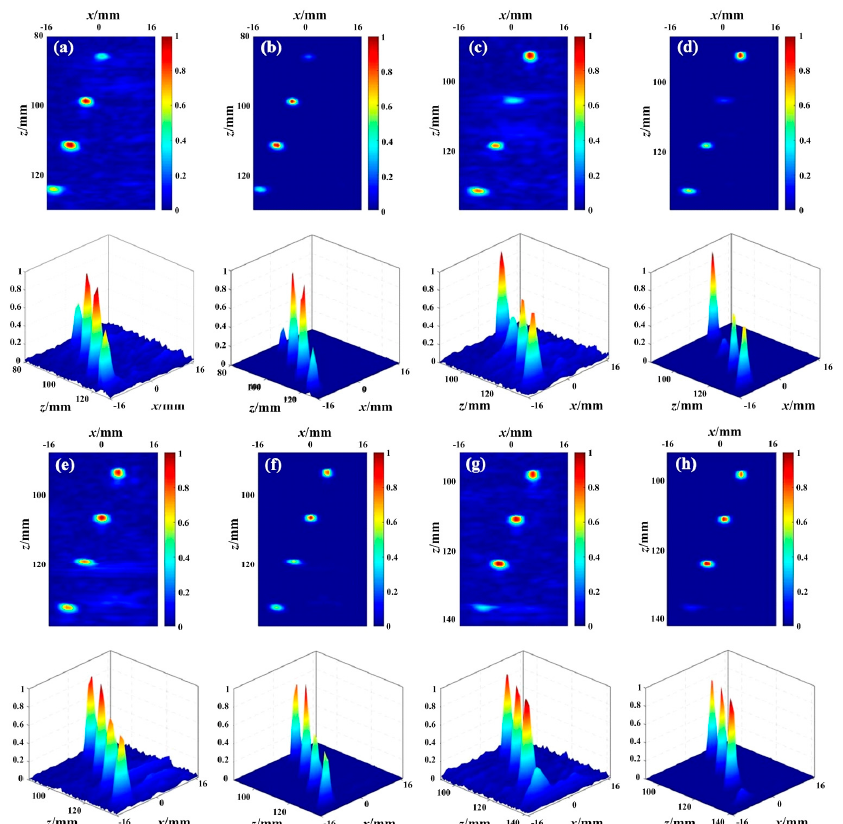
Figure 6. The PCSV and (PCSV) σ factors of different defects covered by the interface echo: PCSV and its 3D display of ( a ) the fourth defect covered; ( c ) the fifth defect covered; ( e ) the sixth defect covered; ( g ) the seventh defect covered; and PCSV with σ = 2 and its 3D display of ( b ) the fourth defect covered; ( d ) the fifth defect covered; ( f ) the sixth defect covered; ( h ) the seventh defect cov- ered.